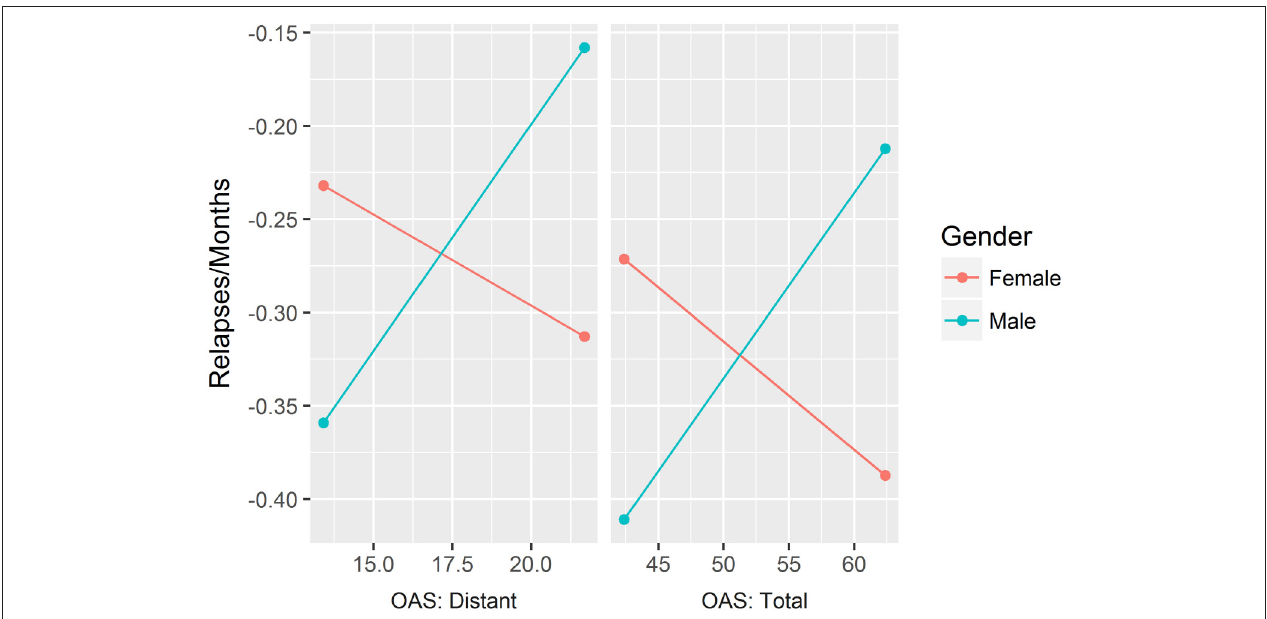
FIGURE 2 | Simple slope analyses of the effects of 2 OAS scales (i.e, Distant and Total) on the rate of relapses per